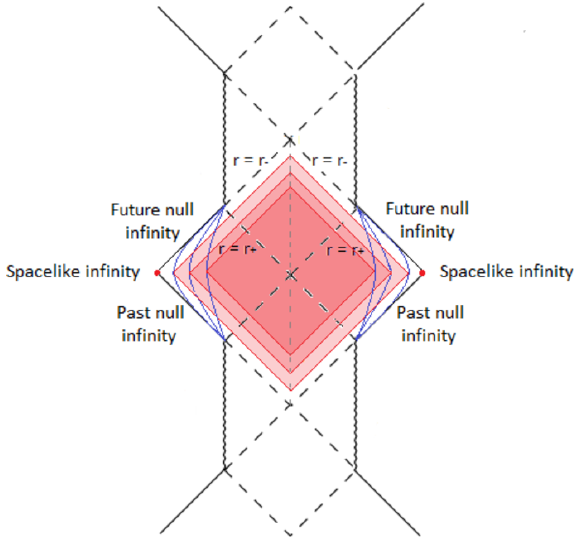
Figure 4 . In WAdS the causal structure resembles the one of asymptotically Minkowski spacetime. Regularization A would give a WDW patch with a corner which is located at the spacelike